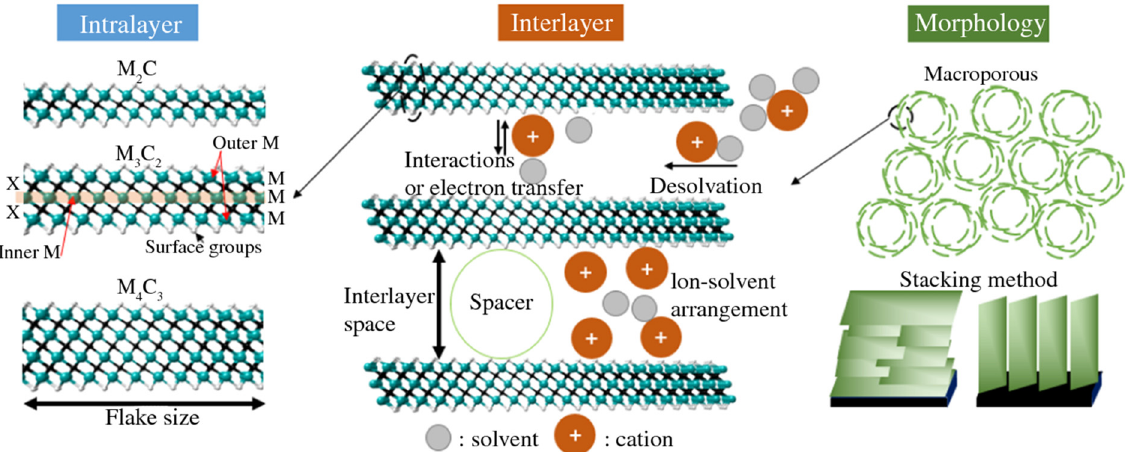
Figure 10. Rate determination of 2D materials at three levels: intra and inter-layer, and electrode morphology [77].